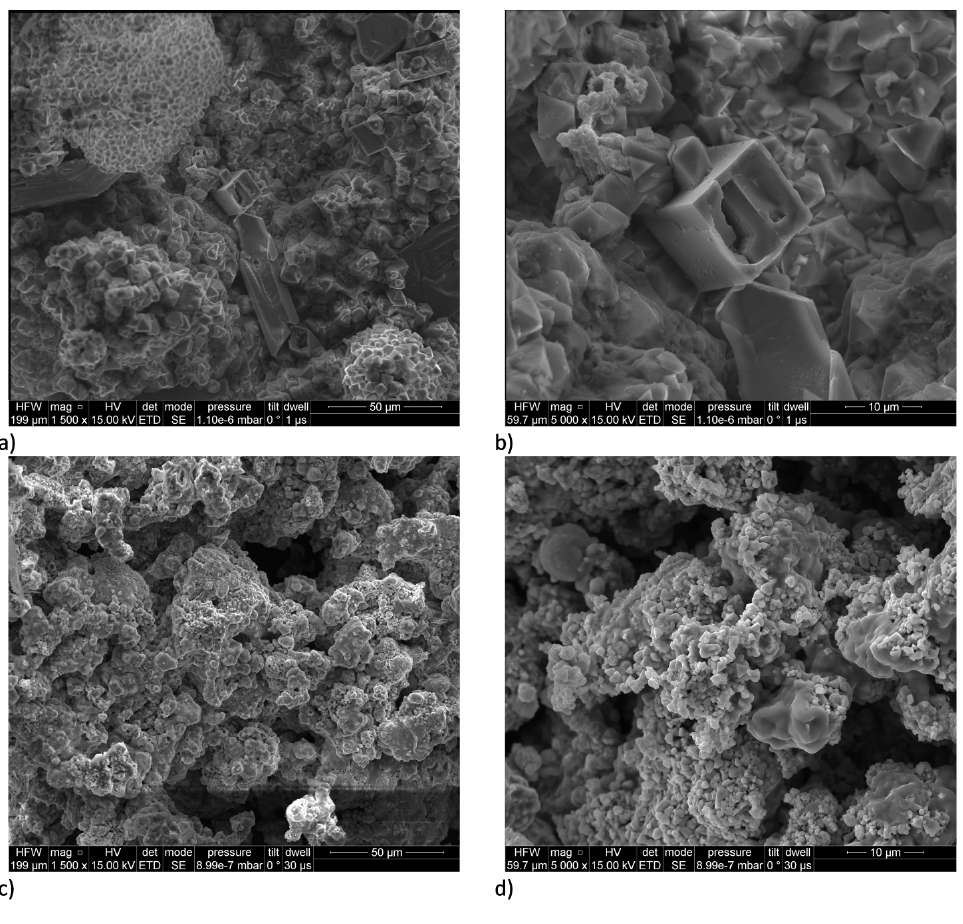
Figure 3. Result of SEM analysis for combustion products of samples Zn2 and Zn7. ( a )—Zn2 with × 1500 magnification; ( b )—Zn2 with × 5000 magnification; ( c )—Zn7 with × 1500 magnification; ( d )—Zn7 with × 5000